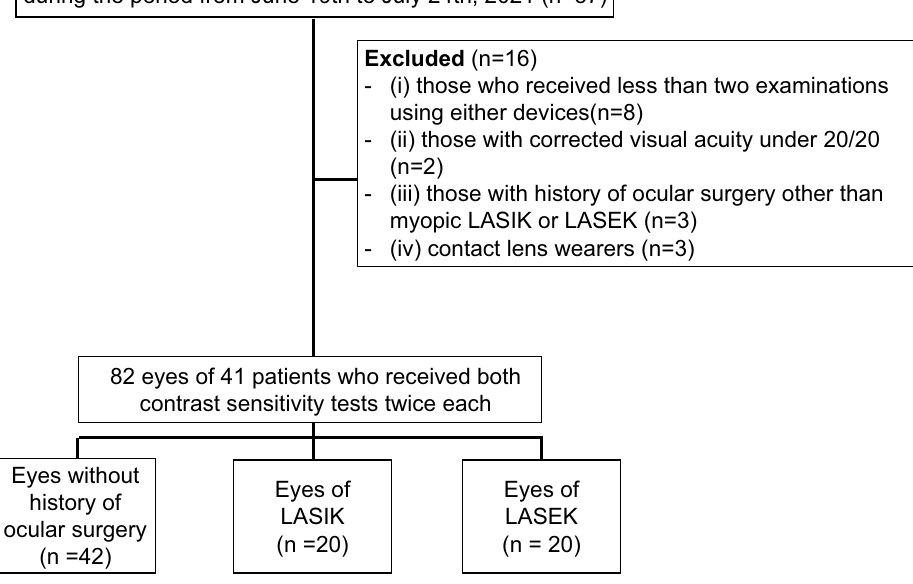
Figure 1. Flowchart of the study population. LASIK, laser-assisted in situ keratomileusis; LASEK, laser-assisted sub-epithelial keratectomy; s/p, status